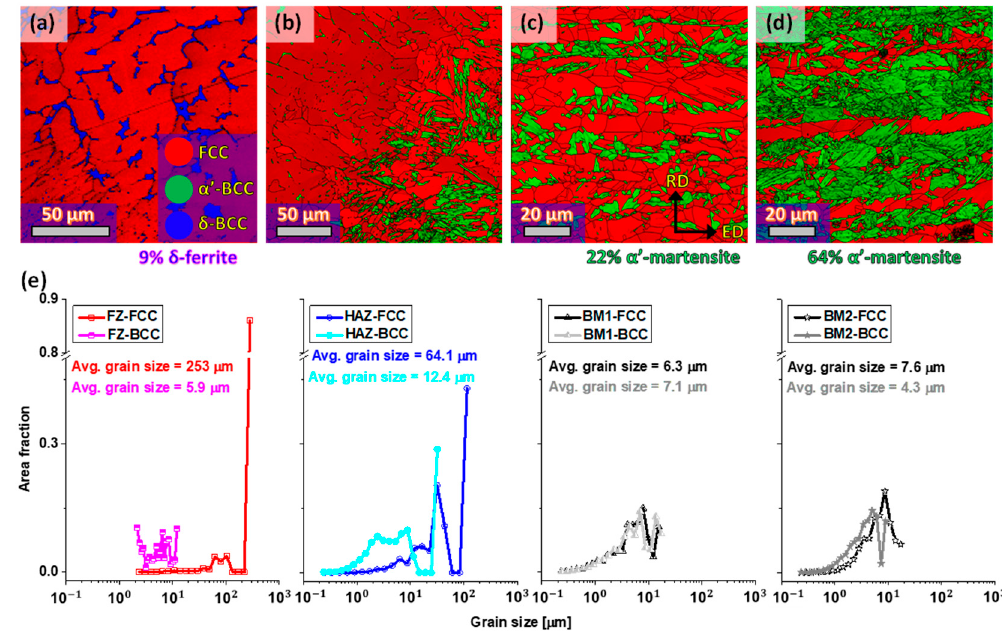
Figure 5. Identification phase maps overlapped on the image quality map for the ( a ) FZ, ( b ) fusion line between the FZ and HAZ, ( c ) BM1, ( d ) BM2, and ( e ) grain size distributions for all the phases in the analyzed zones.